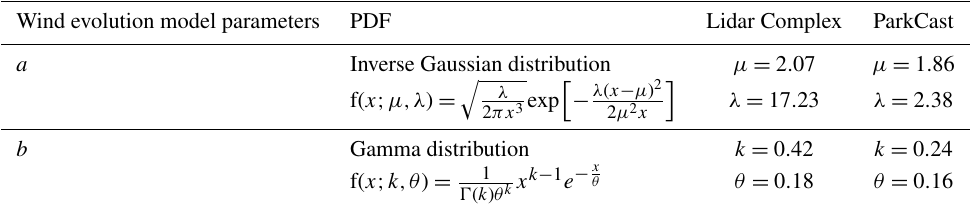
Figure 6. Distribution of wind evolution model parameters. (a, b) Lidar Complex. (c, d) ParkCast. The curves show the corresponding fitted probability density function. Table 3. Parameters of the fitted probability density